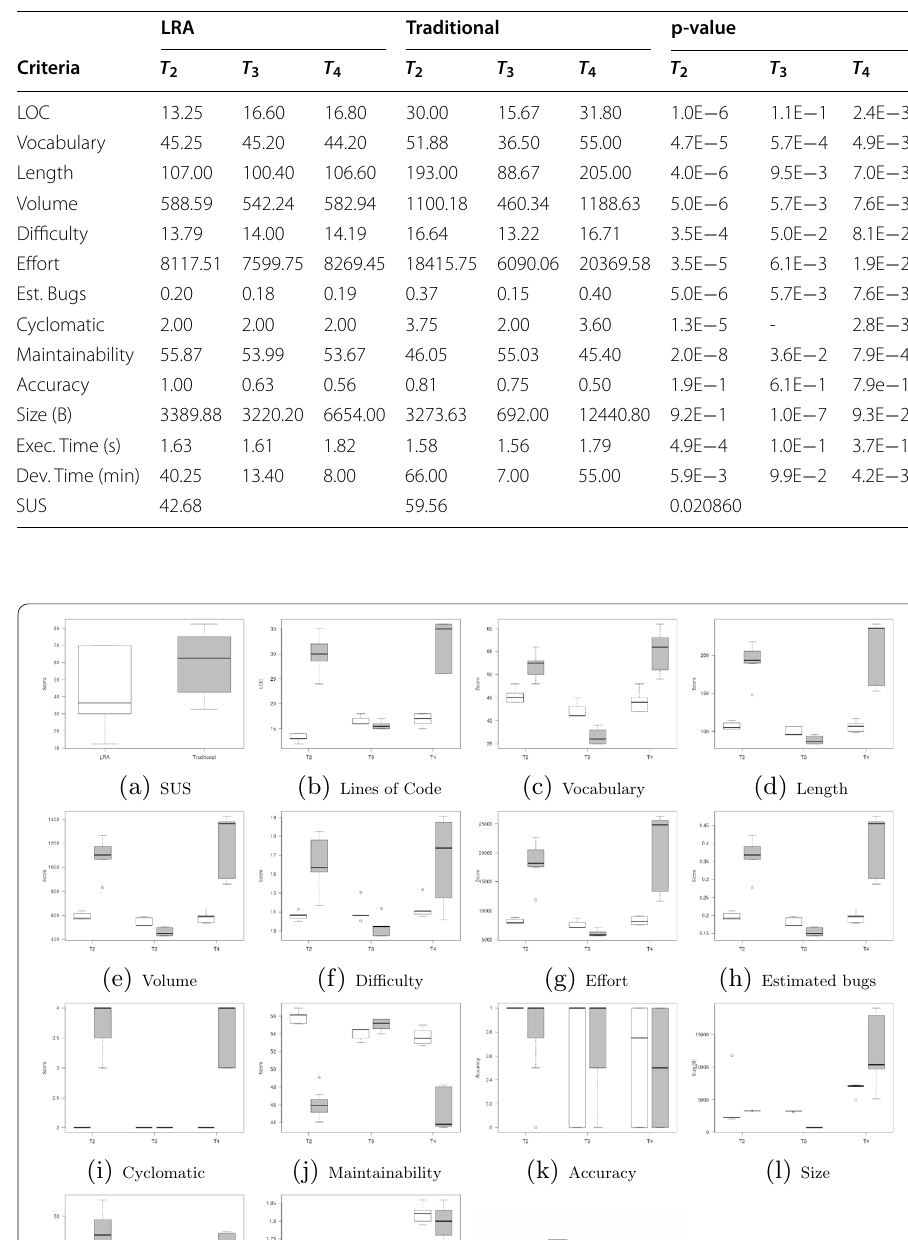
Table 3 Results of the effectiveness evaluation of LRA